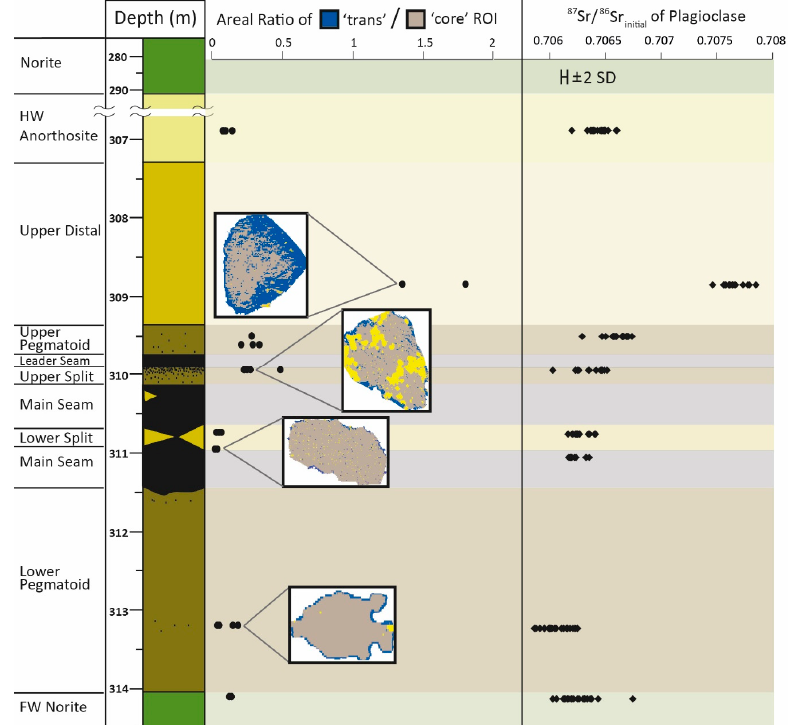
Figure 12. Ratios of the areas defined as ‘trans’ and ‘core’ orthopyroxene ROI (left). 87 Sr/ 86 Sr initial ratios of plagioclase (right); the indicated 2SD error (±0.00006) is valid for all 87 Sr/ 86 Sr initial ratios and was obtained through repeated analysis of plagioclase standard MIR a (n = 84).